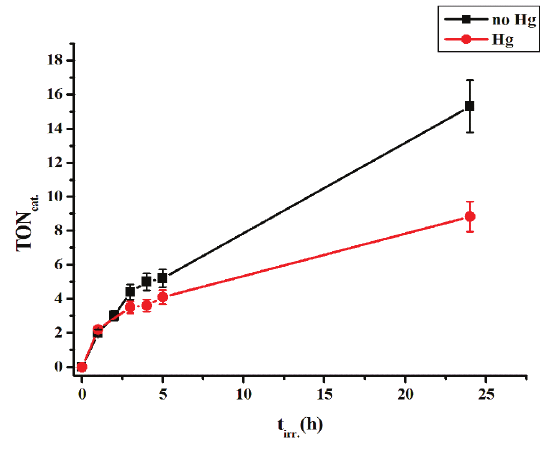
Figure 11: UV-Vis of the system ( 2 ) (64μΜ) / PS: [ReBr(CO) (0,5mM) / ΤΕΟΑ (1M) / AcOH (0,1M) in acetone, before (black) and during irradiation.